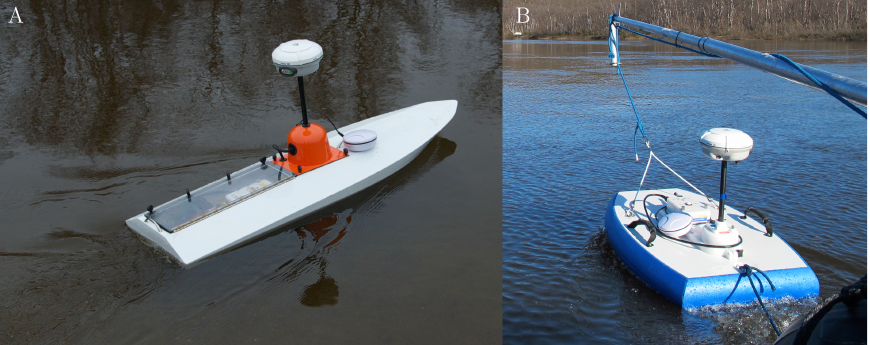
Figure 3. ADCP-GNSS set-up on a remote-controlled boat ( A ) and on the Hydroboard tethered to a zodiac ( B ). A Trimble R8 GNSS receiver is mounted on the GPS pole of the ADCP exactly above the sensor, and the ADCP’s GPS antenna is mounted on the deck of the